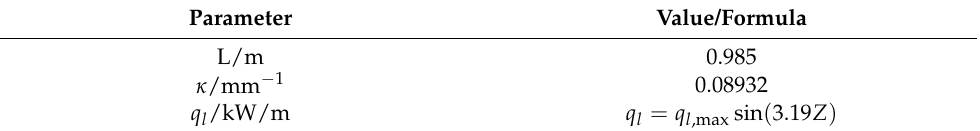
Figure 7. The numerical simulation model of Sun and Zhang [20]. Table 3. The parameters of the numerical simulation model of Sun and Zhang [20].